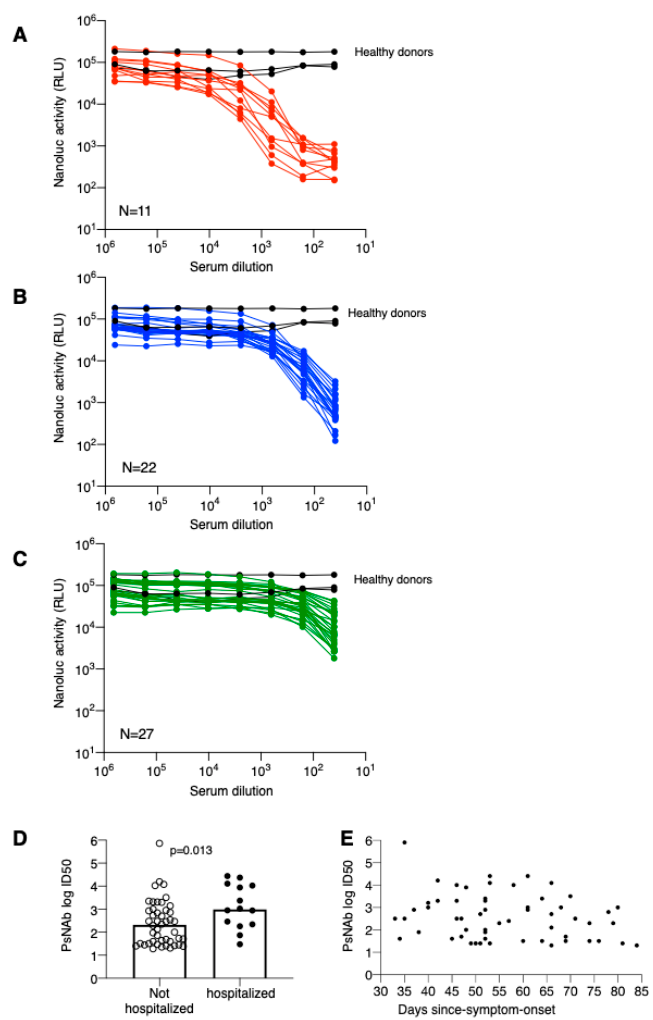
Figure 3. Neutralization curves of individual sera were measured using pseudotype virus assay. The data are plotted according to neutralization strength with high PsNAb ( A ), medium PsNAb ( B ) and low PsNAb ( C ). Black curves denote sera from healthy donors. ( D ) Comparison of pseudotype virus PsNAb ID50 in not hospitalized and hospitalized patients. p value is from an unpaired nonparametric t -test. ( E ) Pseudotype virus PsNAb ID50 plotted as measured days since symptom onset. Importantly, NAb ID50 titers significantly correlated with the complete spike AUC values (Pearson’s r = 0.78, 95% CI: 0.66 to 0.86, p < 0.0001) (Figure 4A) and spike RBD AUC values (Pearson’s r = 0.81, 95% CI: 0.70 to 0.88, p < 0.0001) (Figure 4B), and only a marginal association emerged with the nucleocapsid AUC values (Pearson’s r = 0.26, 95% CI: 0.01 to 0.48, p = 0.05) (Figure 4C).